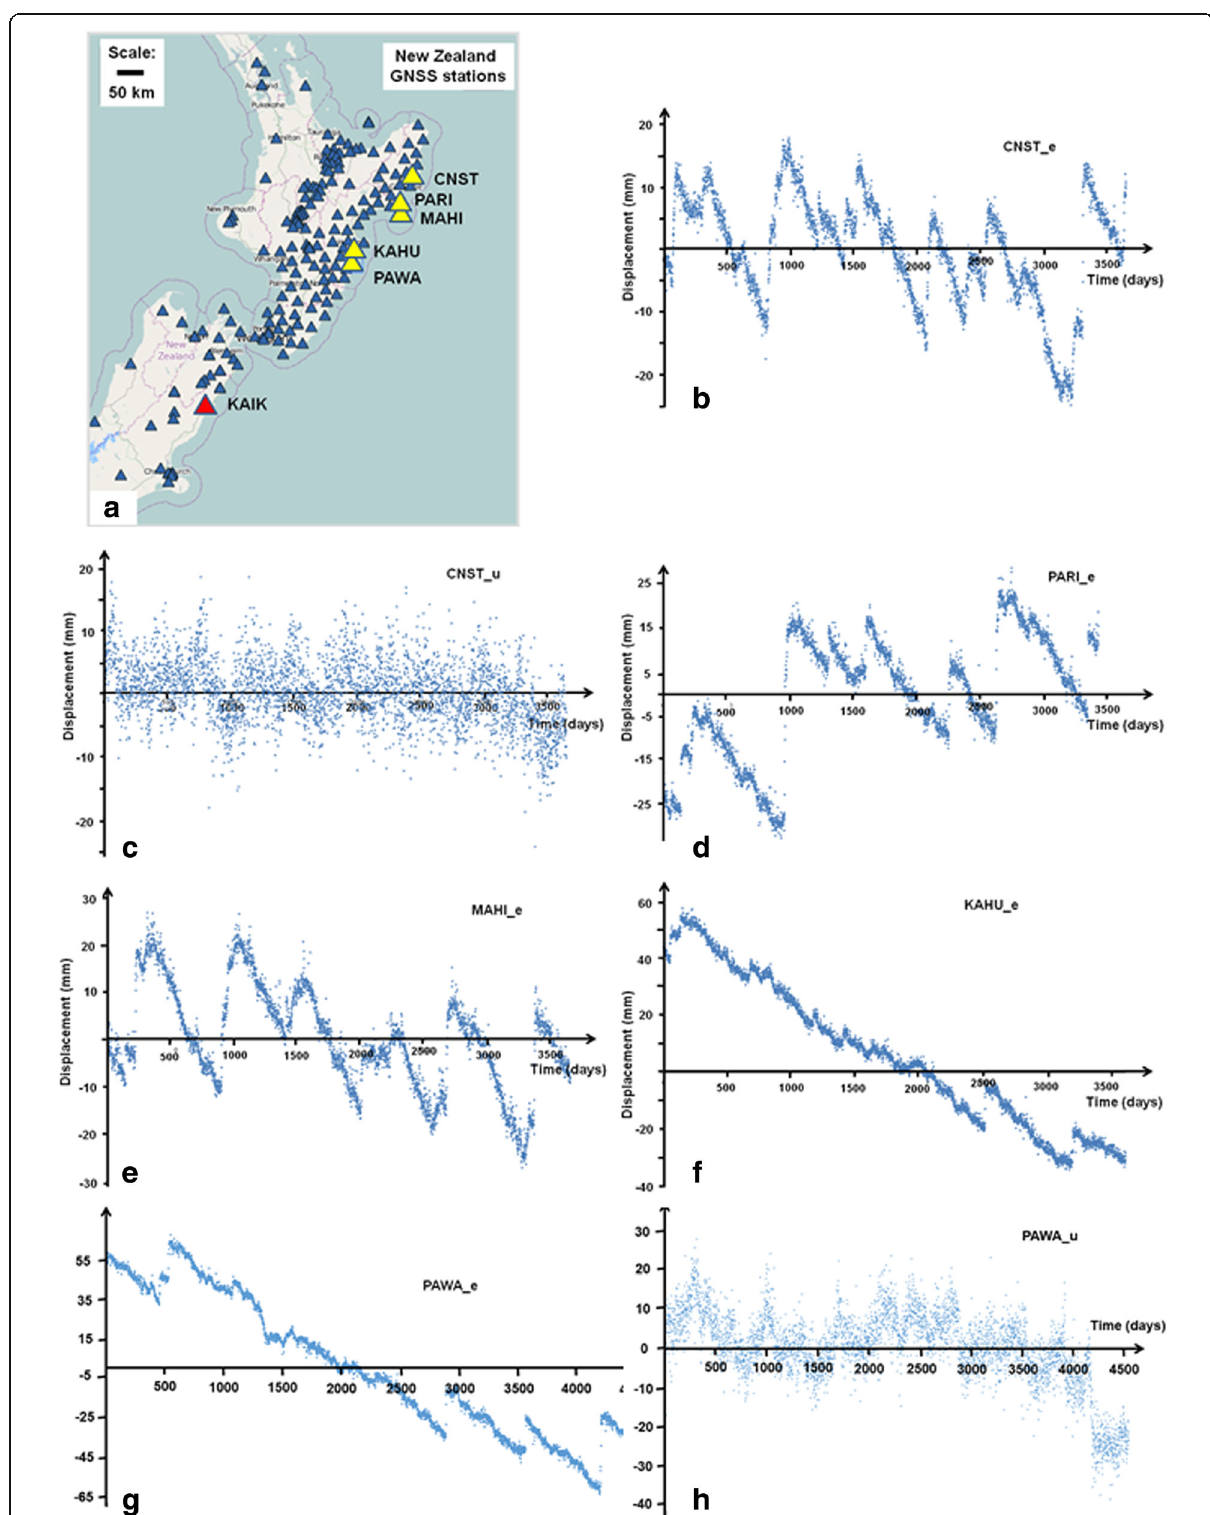
Fig. 11 Raw daily data for components of displacement from five GNSS stations on the North Island of New Zealand. a Locality map. The five stations are shown as yellow stars. The red star is station KAIK on the South Island that is examined for synchronicity with stations CNST and PAWA on the North Island later in the paper. b CNST_e. c CNST_u. d PARI_e. e MAHI_e. f KAHU_e. g PAWA_e. h